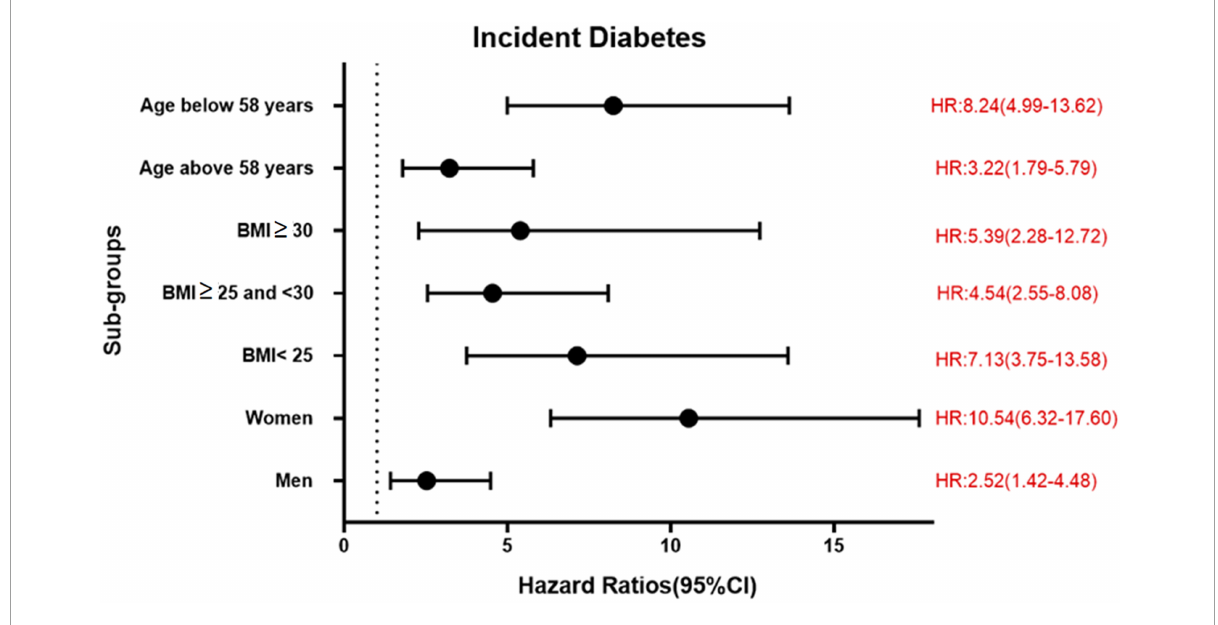
FIGURE1 Association between per unit increase of TyG index and incident diabetes in different sub-groups in MDCS-CV.